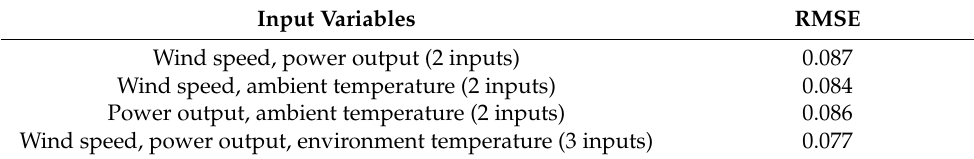
Table 1. The accuracy of the prediction models considering different input parameters.